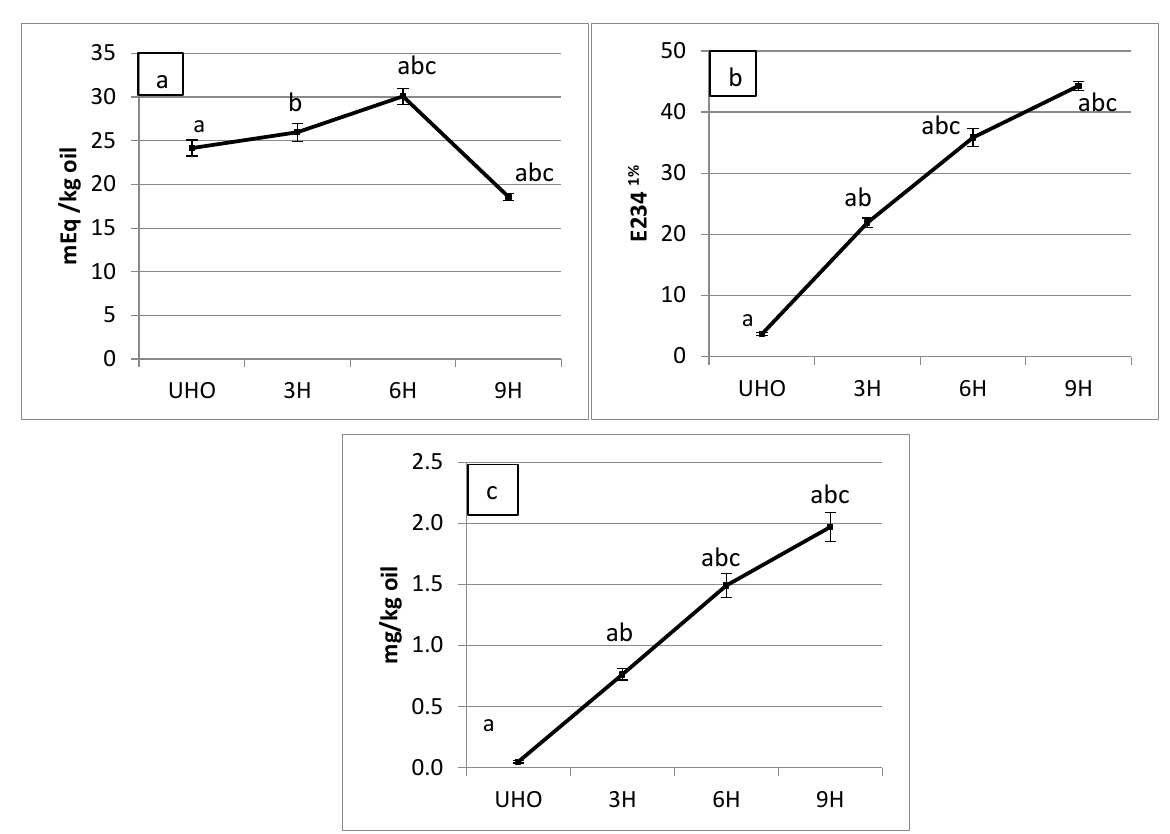
Figure 1. Products of lipid oxidation in unheated and heated vegetable oil. Mean ± SEM peroxide value ( a ), conjugated dienes ( b ) and aldehydes ( c ) of soybean oil unheated (UHO) or heated for 3H, 6H or 9H. Mean differences were determined by Kruskal Wallis test followed by pairwise comparisons with Mann–Whitney U. Means with the same letter differ significantly from each other ( p ≤ 0.05).